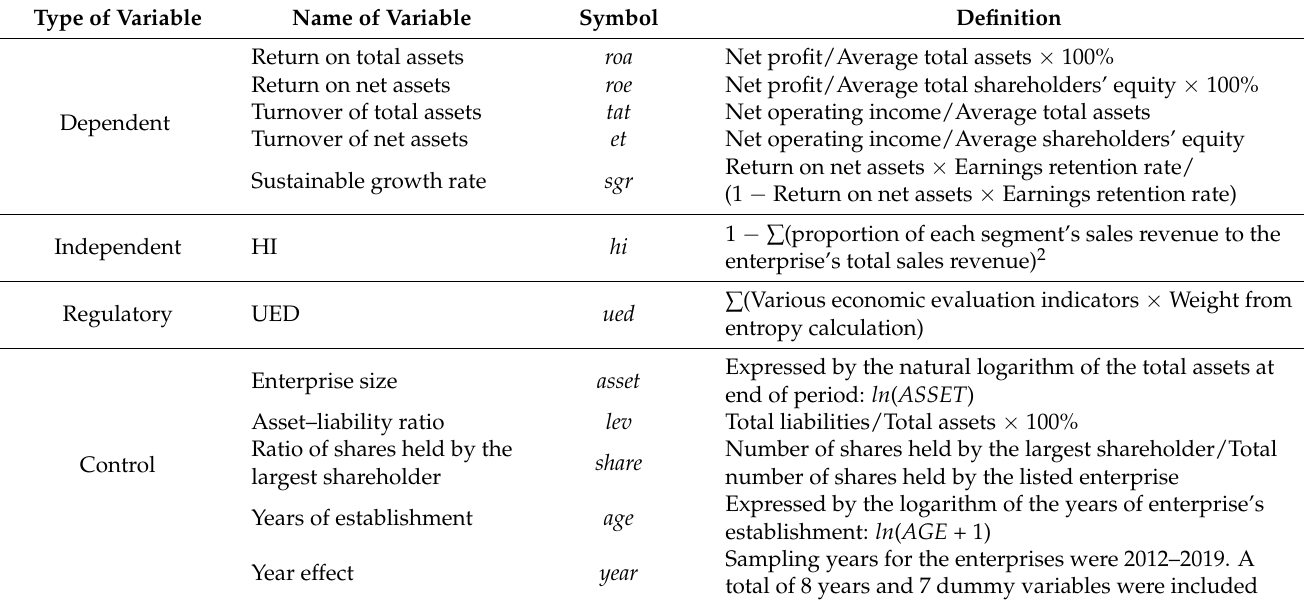
Table 2. List of control